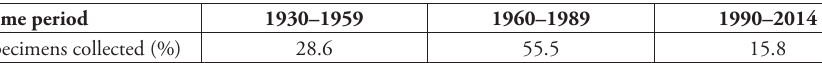
Table 2. Microgastrinae specimens collected in the Canadian Arctic Archipelago during successive time periods between 1930–2014. Data from present